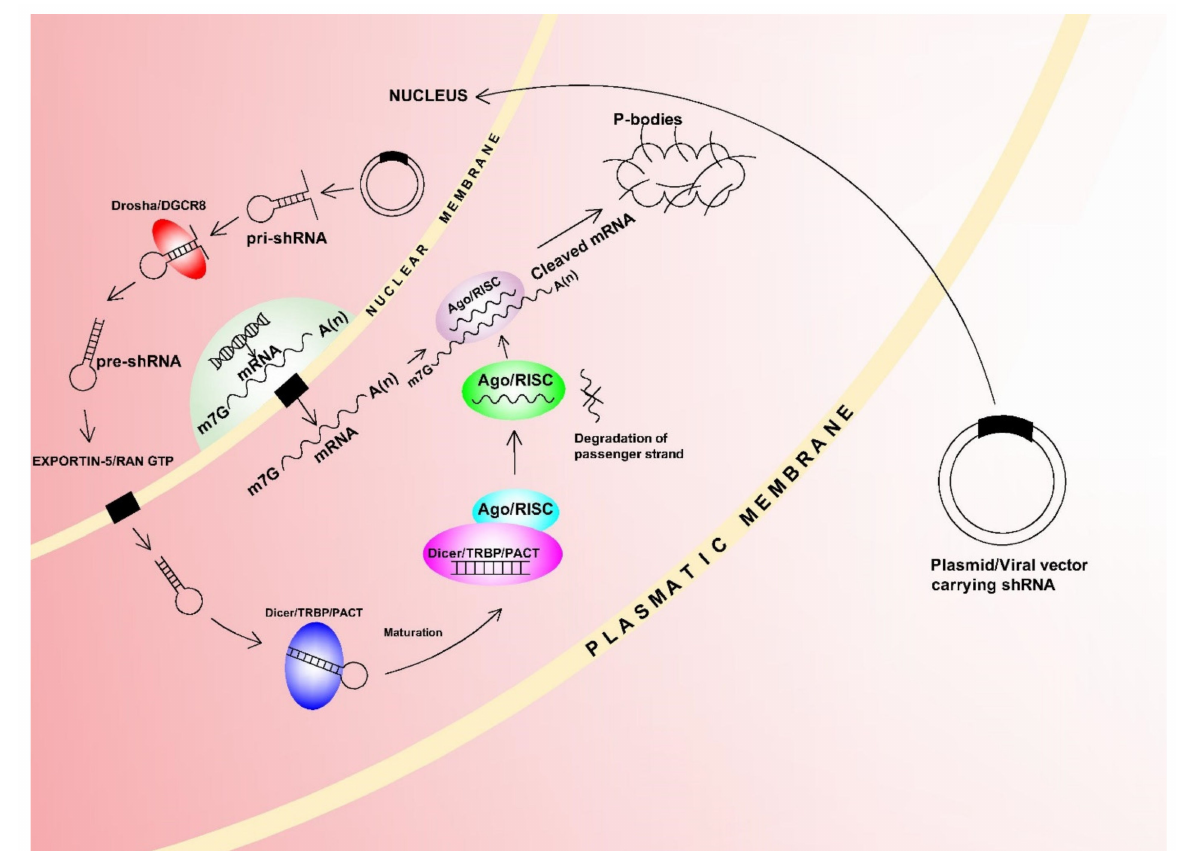
Figure 5. shRNA mechanism action . shRNAs must be encoded in an appropriate expression vector for delivery to the nucleus for transcription. The shRNAs are transcribed by either RNA polymerase II or III, depending on the promoter driving their expression. The pri-shRNA primary transcript is recognised by the Drosha/DGCR8 complex and processed to precursor pre-shRNA. These shRNAs are then transported into the cytoplasm via Exportin 5, loaded into the Dicer/PRBT/PACT complex and processed to mature shRNAs. The shRNAs in the DICER complex then associates with the Ago/RISC complex, and this results in mRNA cleavage and degradation or suppression of mRNA translation. Edited with permission from